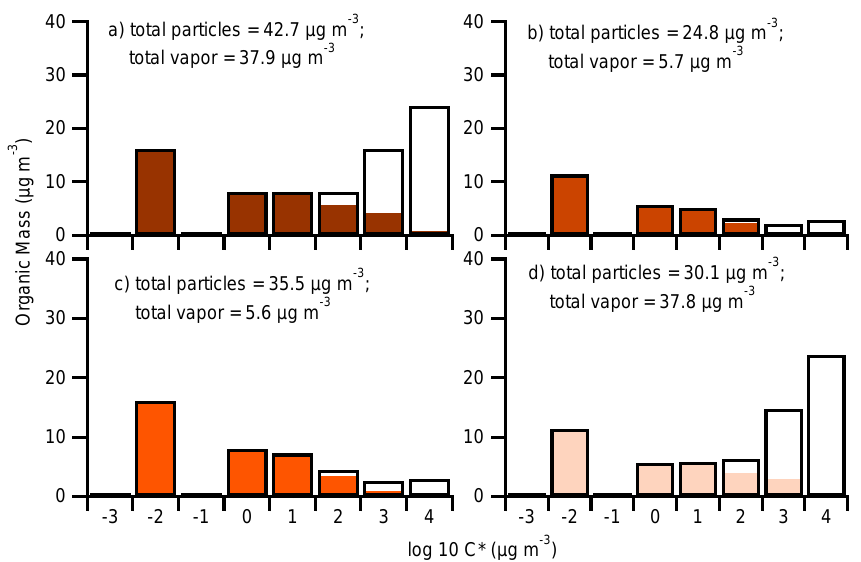
Figure 4. The total organic mass concentration, distributed into its volatility bins, at (a) initial time, i.e., the distribution recommended in May et al. (2013b), for a total initial average organic aerosol mass concentration of 42.7µgm − 3 over the 18 experiments; at the end of the 1h simulation for (b) the base-assumption simulations; (c) the simulation in which particle losses to the walls were turned off; (d) the simulation in which vapor losses to the walls were turned off. Height of bars represents the total mass expected for that volatility bin. Solid regions in the bars represent the organic mass present in the particle phase and open regions represent the mass in the vapor